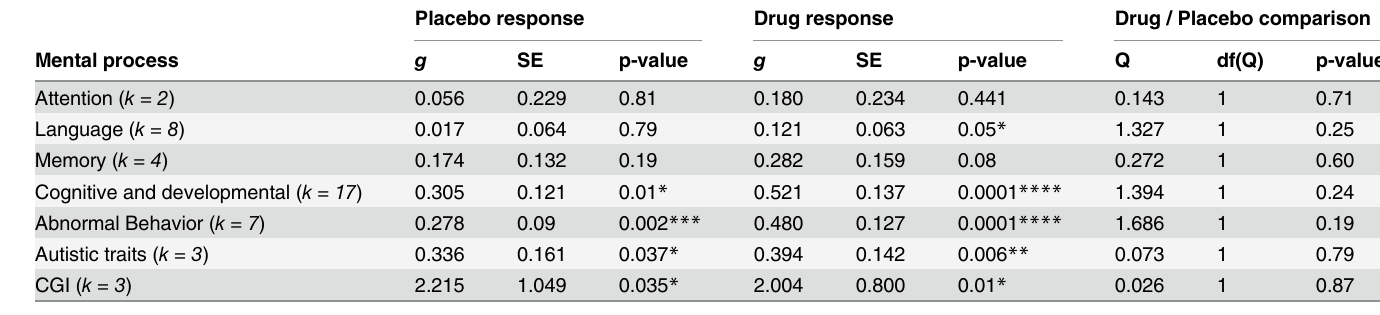
Table 2. Placebo and drug responses by mental process categories. The total number of scales used for assessment of treatment outcomes were grouped into 7 different mental process categories, or domains. Four out of seven domains had a significant placebo response and five out of seven domains had a significant drug response. Clinical Global Impression (CGI) assessments are commonly used as study endpoints in clinical trials. Here, CGI is repre- sented by one category, even if it is not a mental